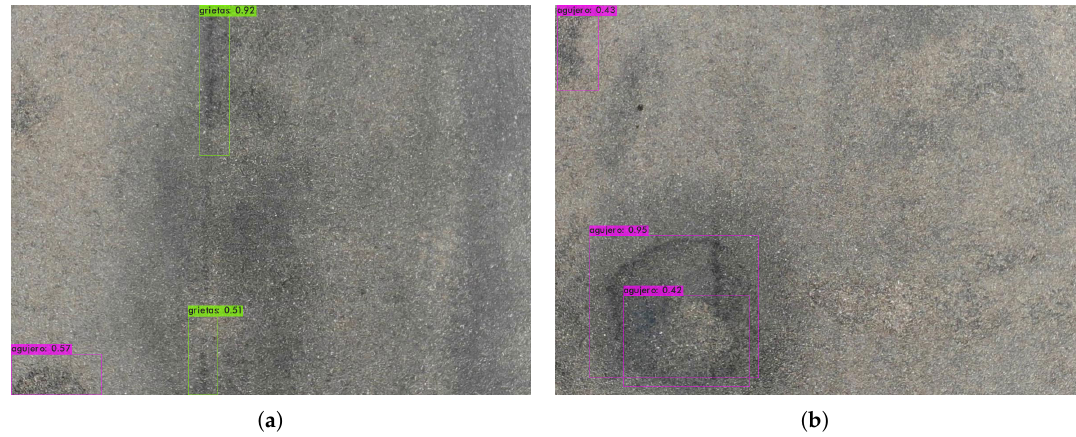
Figure 11. Crack detection and a detection of a pothole inside other. ( a ) Detection of a crack in the track. ( b ) Pothole inside